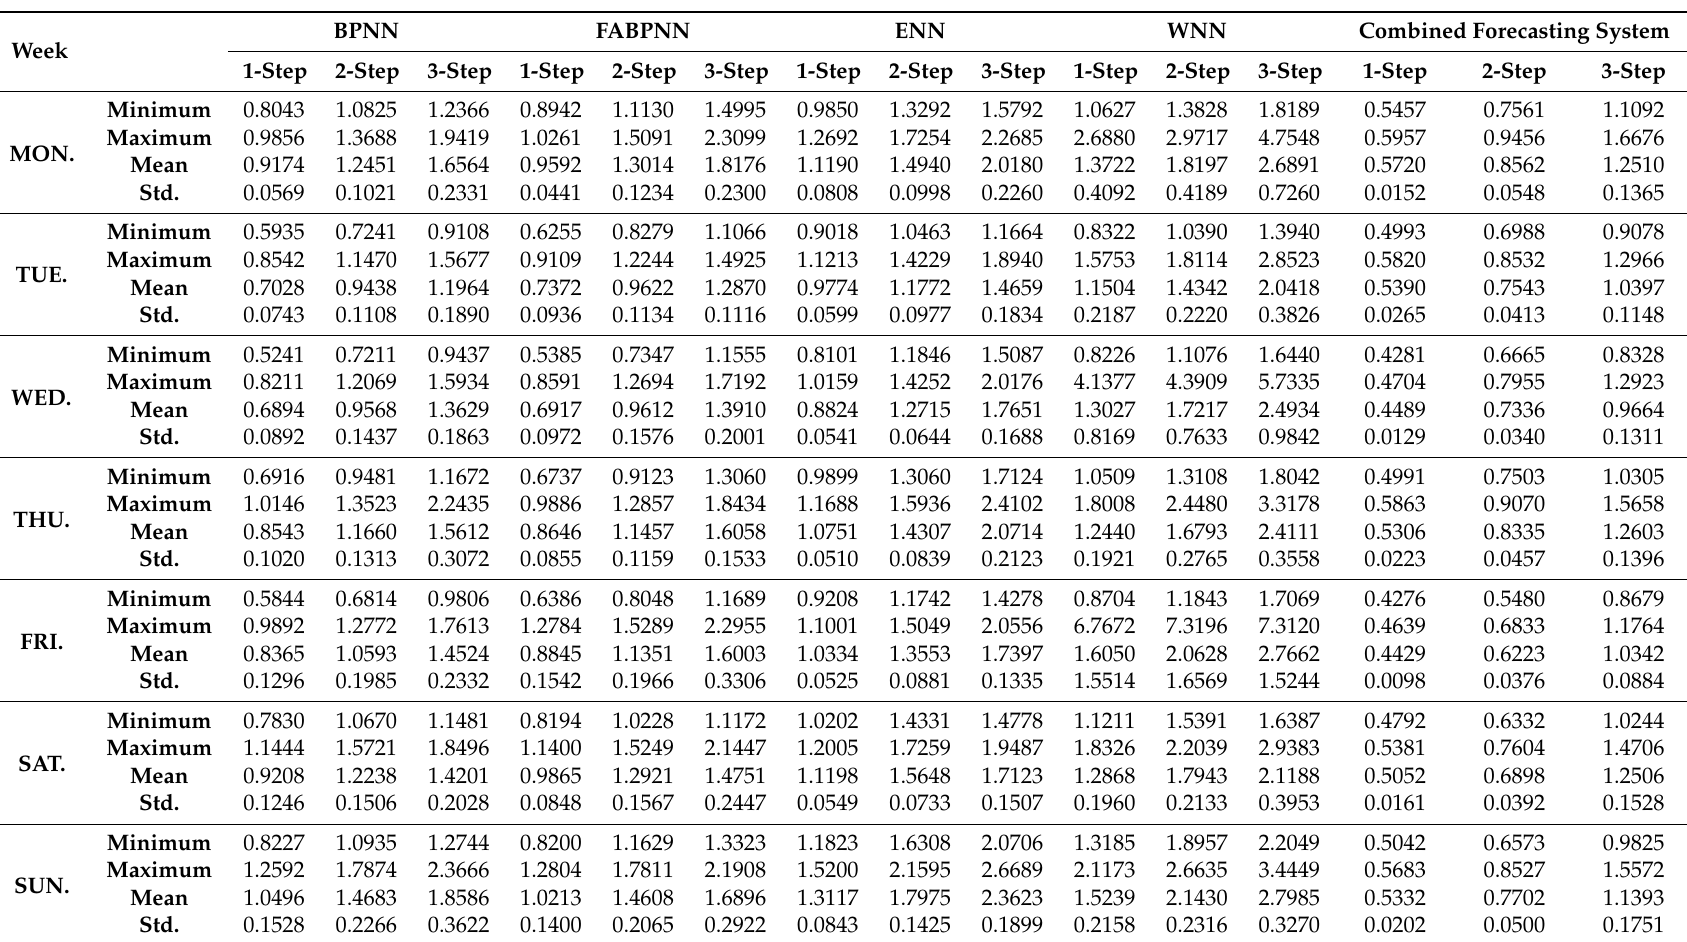
Table 9. Statistical MAPE values of June data from New South